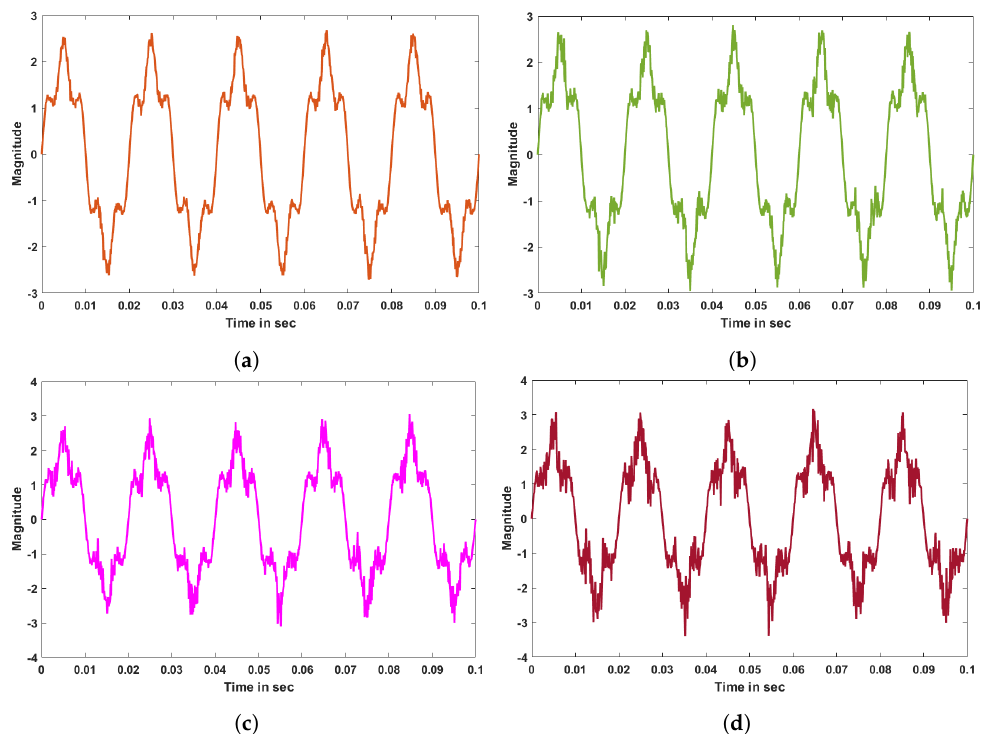
Figure 4. Sinusoidal signals with various combinations of THD and noise levels used for dataset preparation. ( a ) Sinusoidal signal with THD level 50% and noise level 10%. ( b ) Sinusoidal signal with THD level 50% and noise level 20%. ( c ) Sinusoidal signal with THD level 50% and noise level